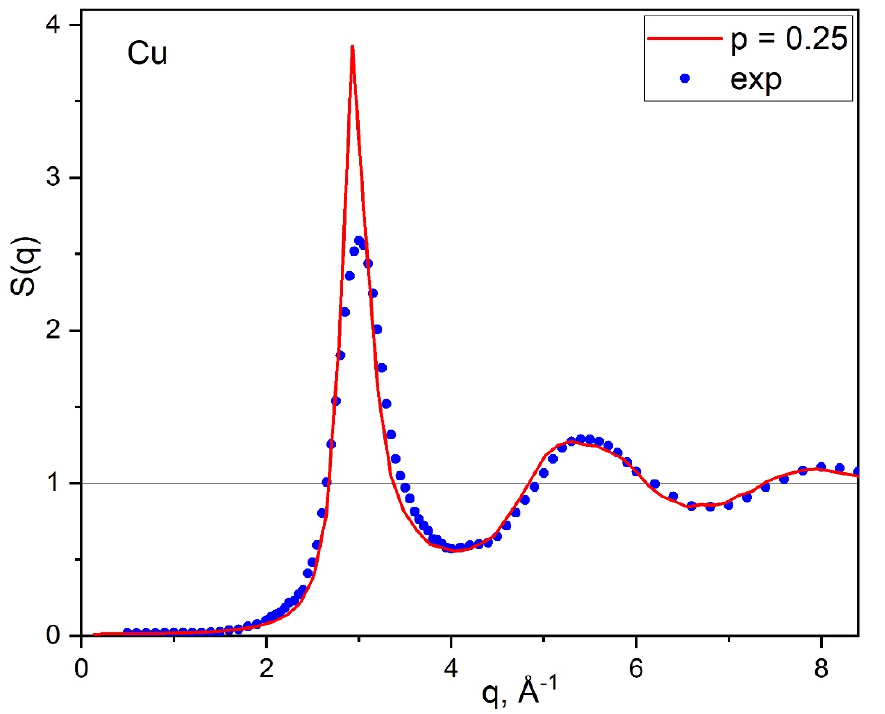
11 of 17 25.0 = p in comparison with experiment